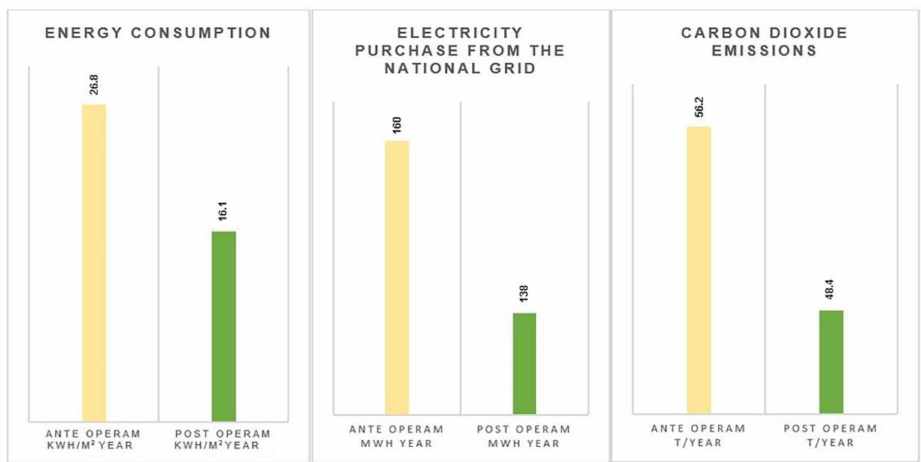
Figure 20. Results of the energy-efficiency